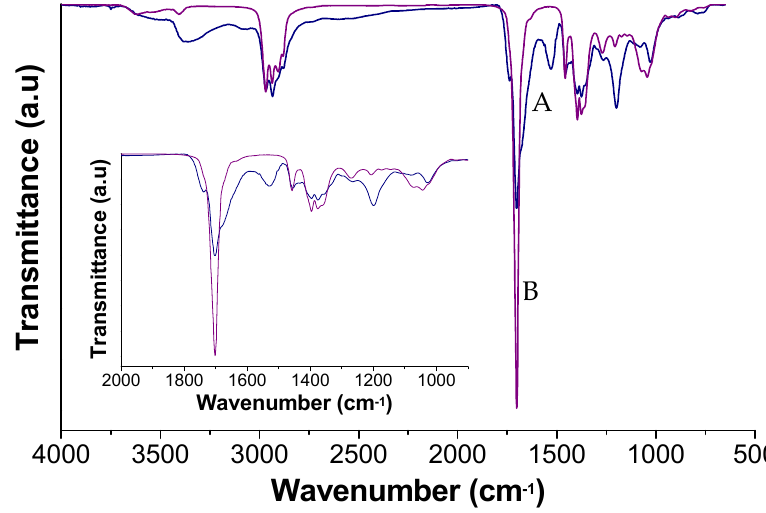
Figure 3. FT-IR spectra of ( A ) PK30 functionalized with Gly-Gly and ( B ) pristine PK30.